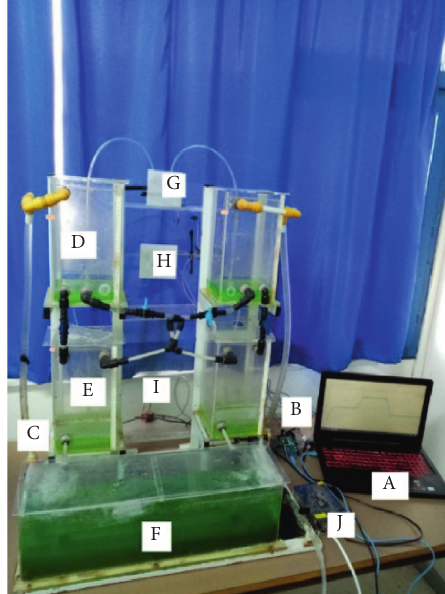
Figure 6: Experimental setup. A: control desk; B: Arduino; C: pump with maximum voltage rating 12V; D: tank 2; E: tank 1; F: basin; G: liquid-level sensor for tank 2; H: liquid-level sensor for tank 1; I: motor driver board; J: ± 12V supply